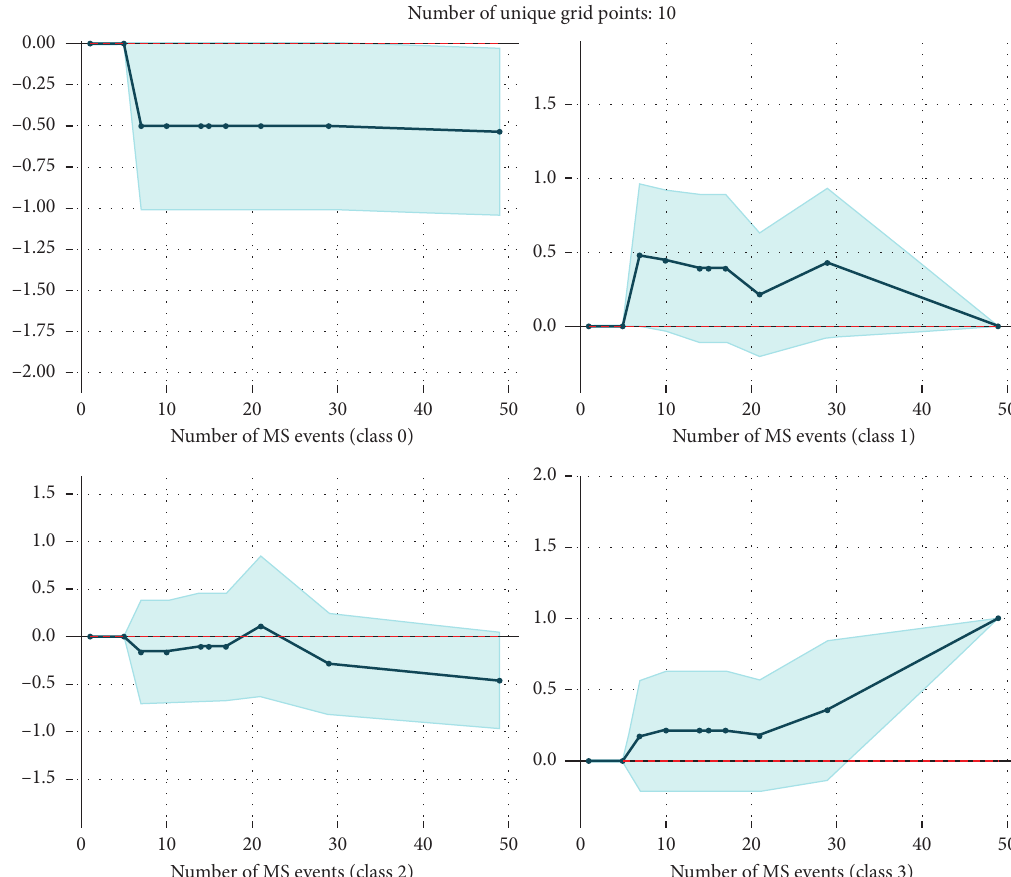
Figure 8: Impact of the number of MS events on rockburst.